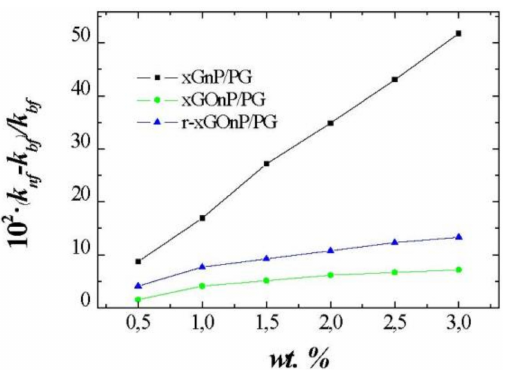
Figure 7. Thermal conductivity enhancements, 100(k nf -k bf )/k bf , for different weight fractions, wt %, of xGnP/PG, xGOnP/PG, and r-xGOnP/PG nanofluids at T = 323.15 K.